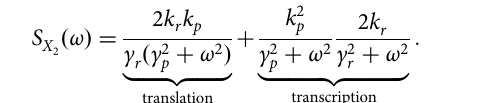
The stationary distribution for this network is Poisson with parameter k / γ . Hence the stationary mean and variance and equal to k / γ and applying formula (13) we can compute the PSD as